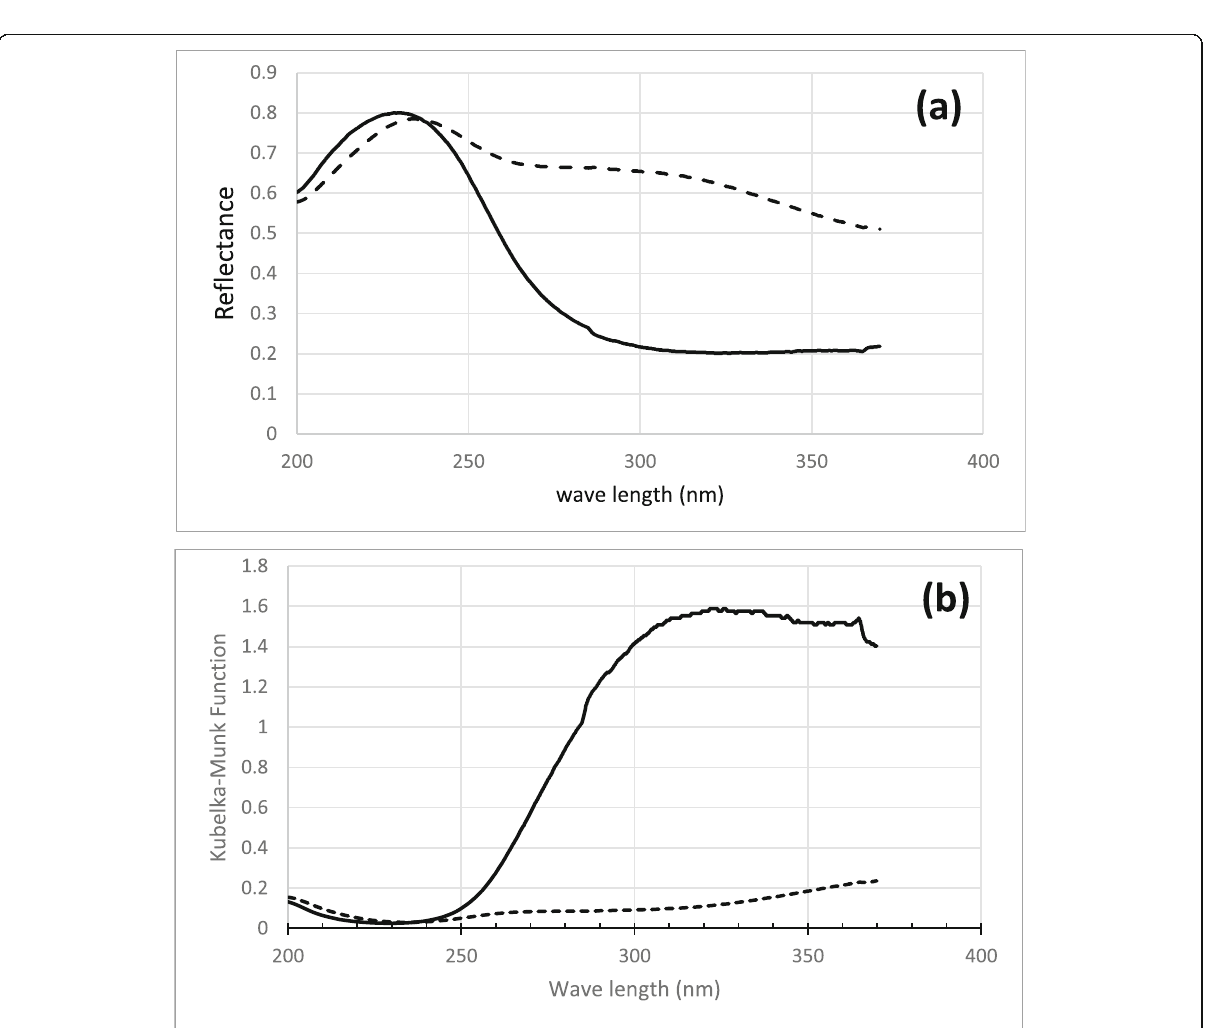
Fig. 5 a UV diffuse reflection spectra and b Kubelka-Munk function F(R) patterns* of chlorinated silica (dotted lines) and SC-2P bonded silica (solid